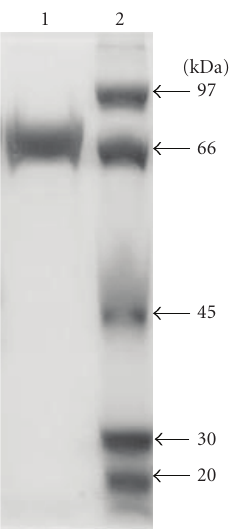
Figure 3: Influence of the operating temperature on the production of soluble US132 CGTase by E. coli ER2566/pSJ8 strain. Protein samples loaded onto the 10% SDS-polyacrylamide gel were stained with Coomassie Brilliant Blue. Lanes 1, 2, and 3: periplasmic fractions obtained from cells cultivated at 37, 19, and 37–19 ◦ C, respectively. Lane M: low molecular weight marker. Lanes 4, 5 and 6: insoluble fractions obtained when cells are cultivated at 37–19, 19, and 37 ◦ C, respectively.